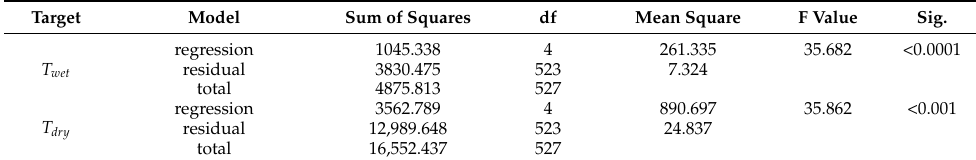
Figure 8. The importance of features in modeling ( a ) T wet and ( b ) T dry . Table 5. The ANOVA results for predicting T wet and T dry .